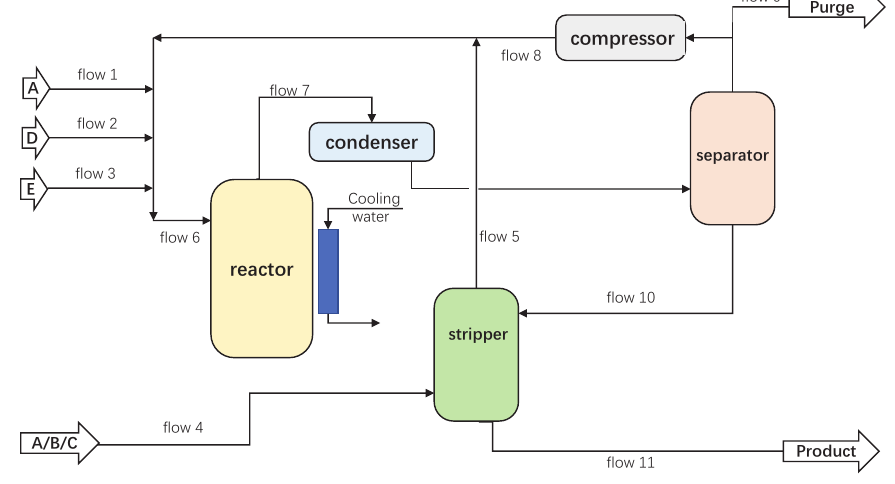
Figure 4. Flowchart of the Tennessee–Eastman (TE) process.